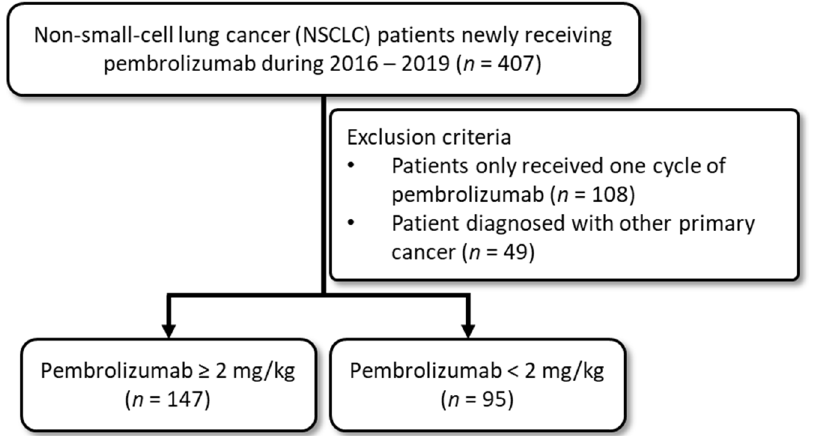
Figure 1. Selection of study cohort from database.